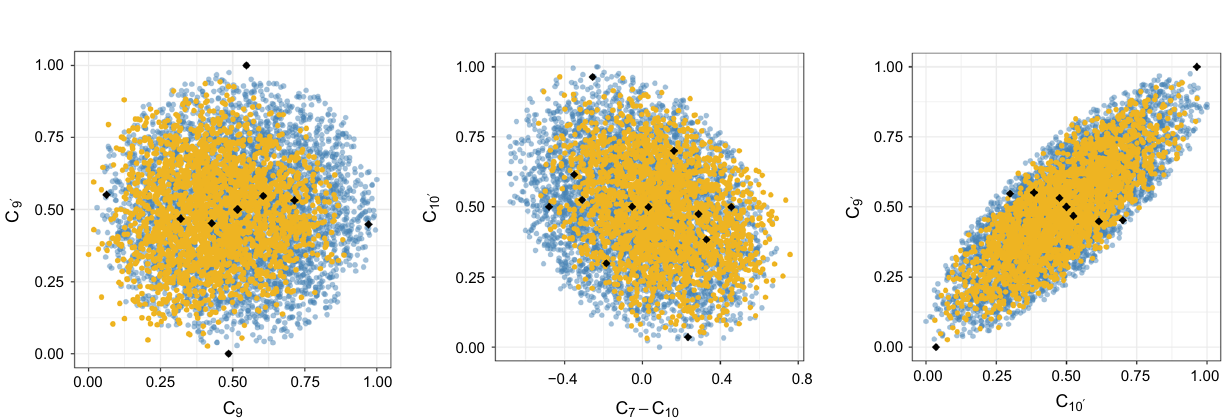
Fig. 2 Threeprojectionsofsix-dimensionalpointsinrescaled C (i.e. each coefficient takes values between 0 and 1) ∈ S 1 σ for the exact numerical calculation (yellow) and the quadratic approximation (blue).